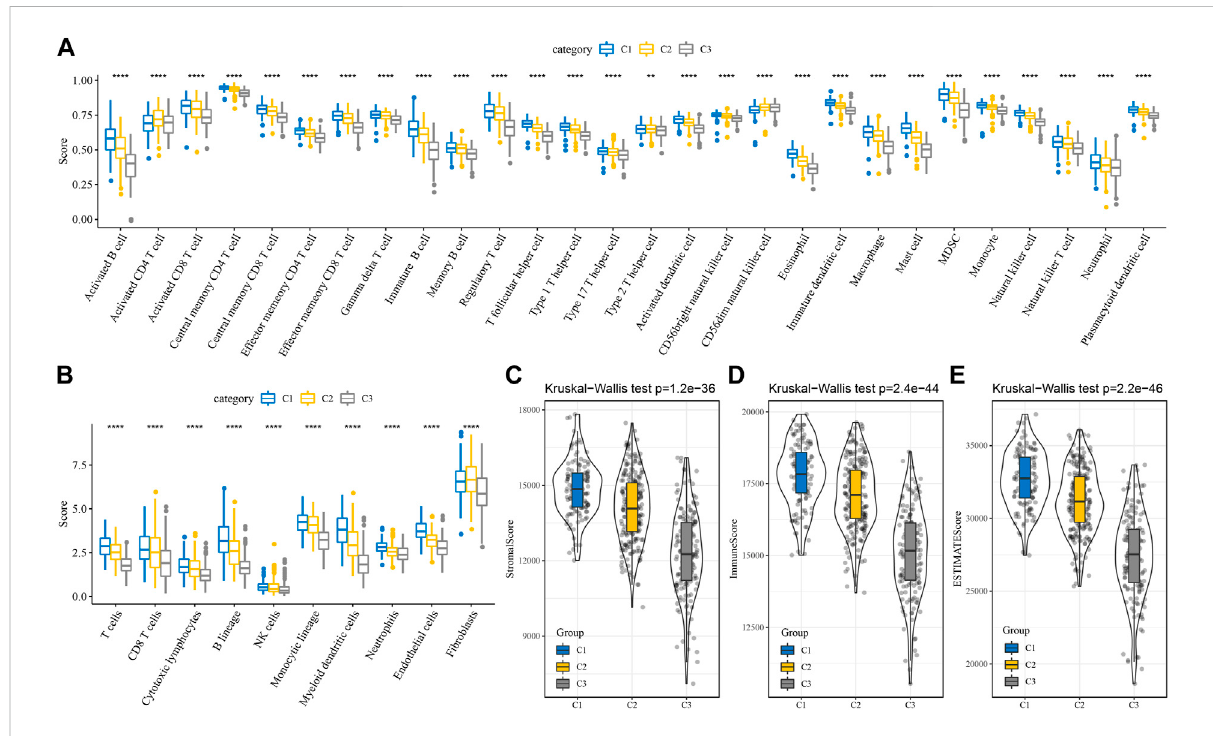
FIGURE 3 Differences of immune microenvironment in different subtypes. (A) Subtype comparison of 28 immune cell scores assessed by ssGSEA; (B) Subtype comparison of 10 immune cell scores assessed by MCP-Counter; (C – E) Subtype comparison of StromalScore, ImmuneScore,